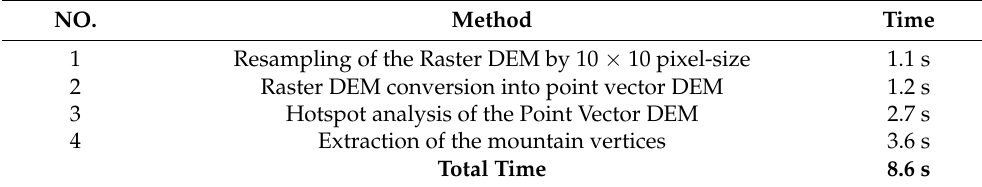
Table 8. The time consumed in extracting mountain vertices for the second dataset using our proposed